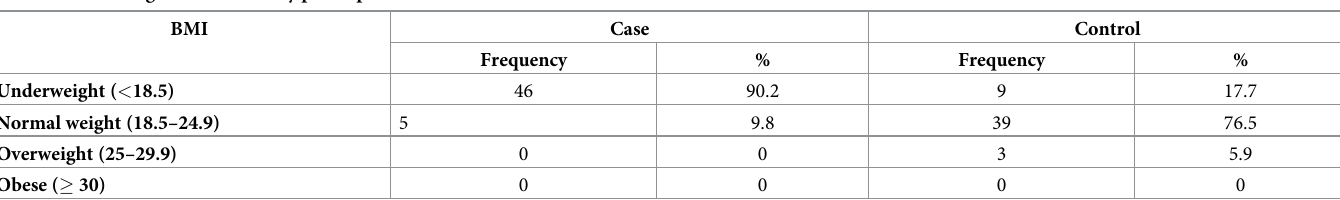
Table 2. BMI categories of the study participants.